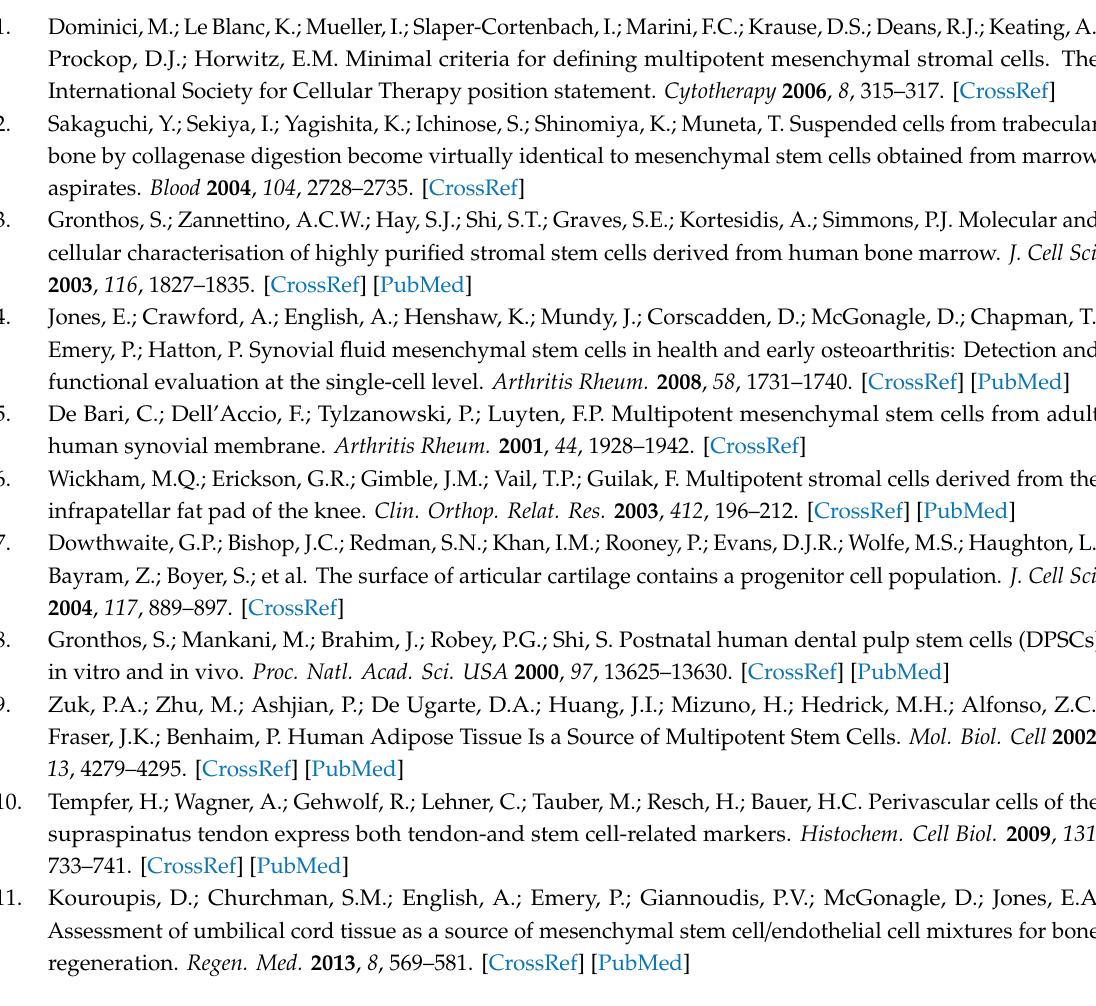
Supplementary Figure S1: 1A ( ACTA1-GATA2 ) Relative gene expression in MSCs of di ff erent origin and 1B ( GHR-WIF1 ) Relative gene expression in MSCs of di ff erent origin, Supplementary Figure S2: Thirty-one genes with no overlapping gene expression between PVB- and FVB-MSCs, Supplementary Table S1: Surgical patient information, Supplementary Table S2: Rheumatoid arthritis patient information and Supplementary Table S3: Taqman assays